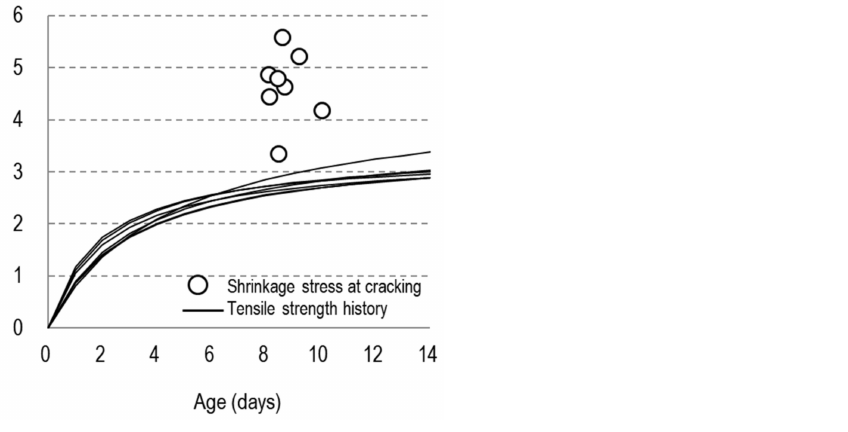
Figure 12. Development of tensile strength and shrinkage stress at cracking.